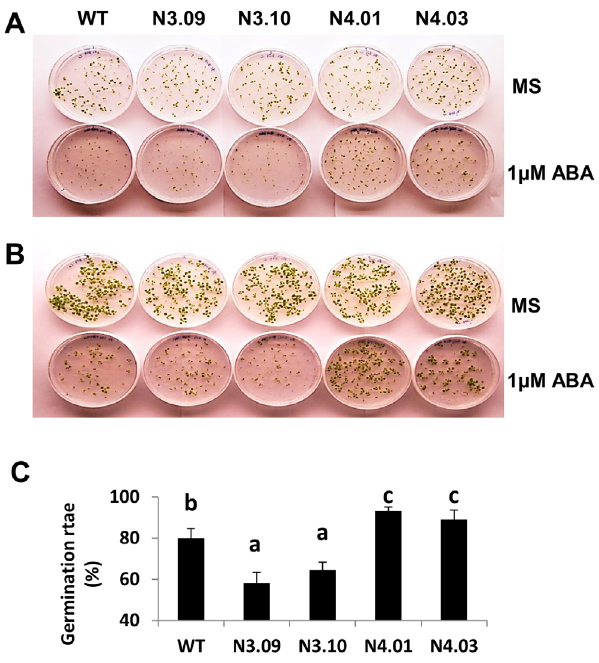
Figure 6. Germination of GmNAC003 and GmNAC004 trans- genic Arabidopsis seeds in response to ABA treatment. Fifty to seventy seeds of the homozygous GmNAC003 and GmNAC004 transgenic and WT plants were sown on agar plates without ABA (MS) or with 1 m M ABA (ABA). (A & B) Plants were 7 and 14 days old, respectively. (C) Quantification of germination rates 5 days after sowing. Different letters denote significant differences at the 95% confidence level using Duncan’s multiple range test from four